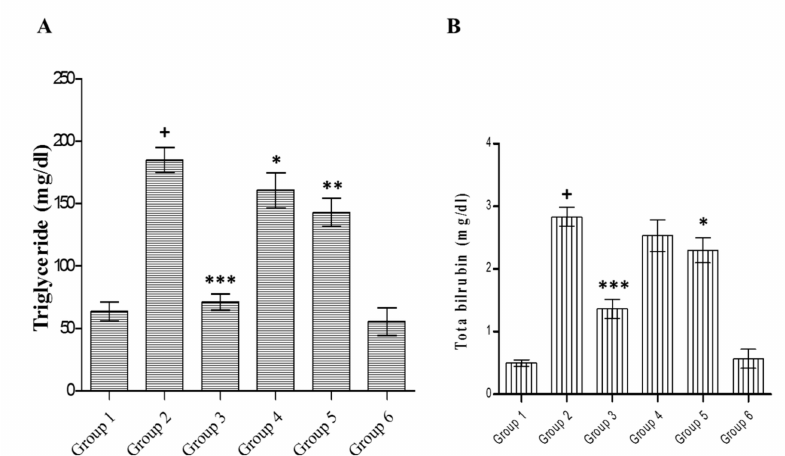
Figure 7. E ff ect of C. lanceolatus methanolic extract on serum triglyceride ( A ) and bilirubin ( B ) levels. The results are expressed as a mean ± SD ( n = 5). Group 1: Normal control; Group 2: Diabetic control; Group 3: Diabetic rats treated with glibenclamide; Group 4: Diabetic rats fed with C. lanceolatus extract (200 mg / kg); Group 5: Diabetic rats fed with C. lanceolatus extract (400 mg / kg); Group 6: C. lanceolatus extract (400 mg / kg) control. + p < 0.001 compared to normal control. * p < 0.05, ** p < 0.01 and *** p < 0.001 compared to the diabetic